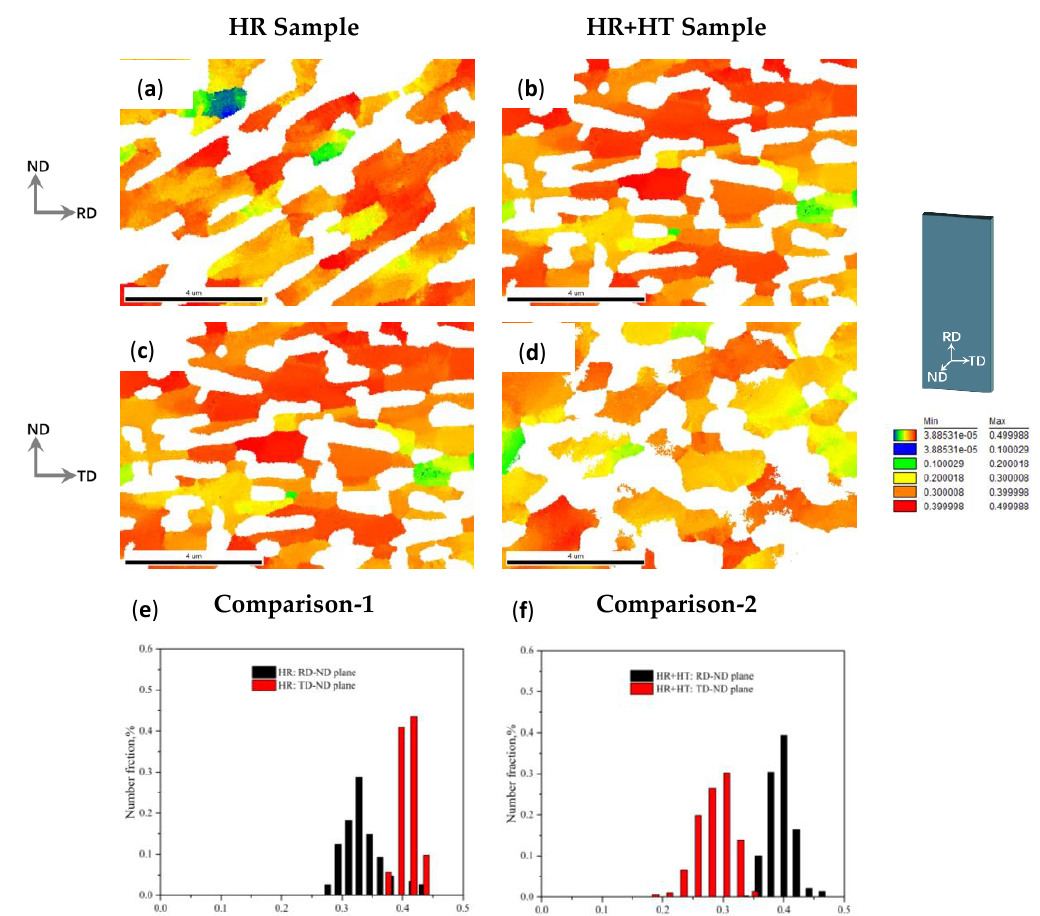
Figure 8. Schmid factor distributions of {110}<1-11> slip system in β phase. ( a , b ): ND-RD plane; ( c , d ): ND-TD plane; ( e ): comparison of ( a ) and ( c ); ( f ): comparison of ( b ) and ( d ).